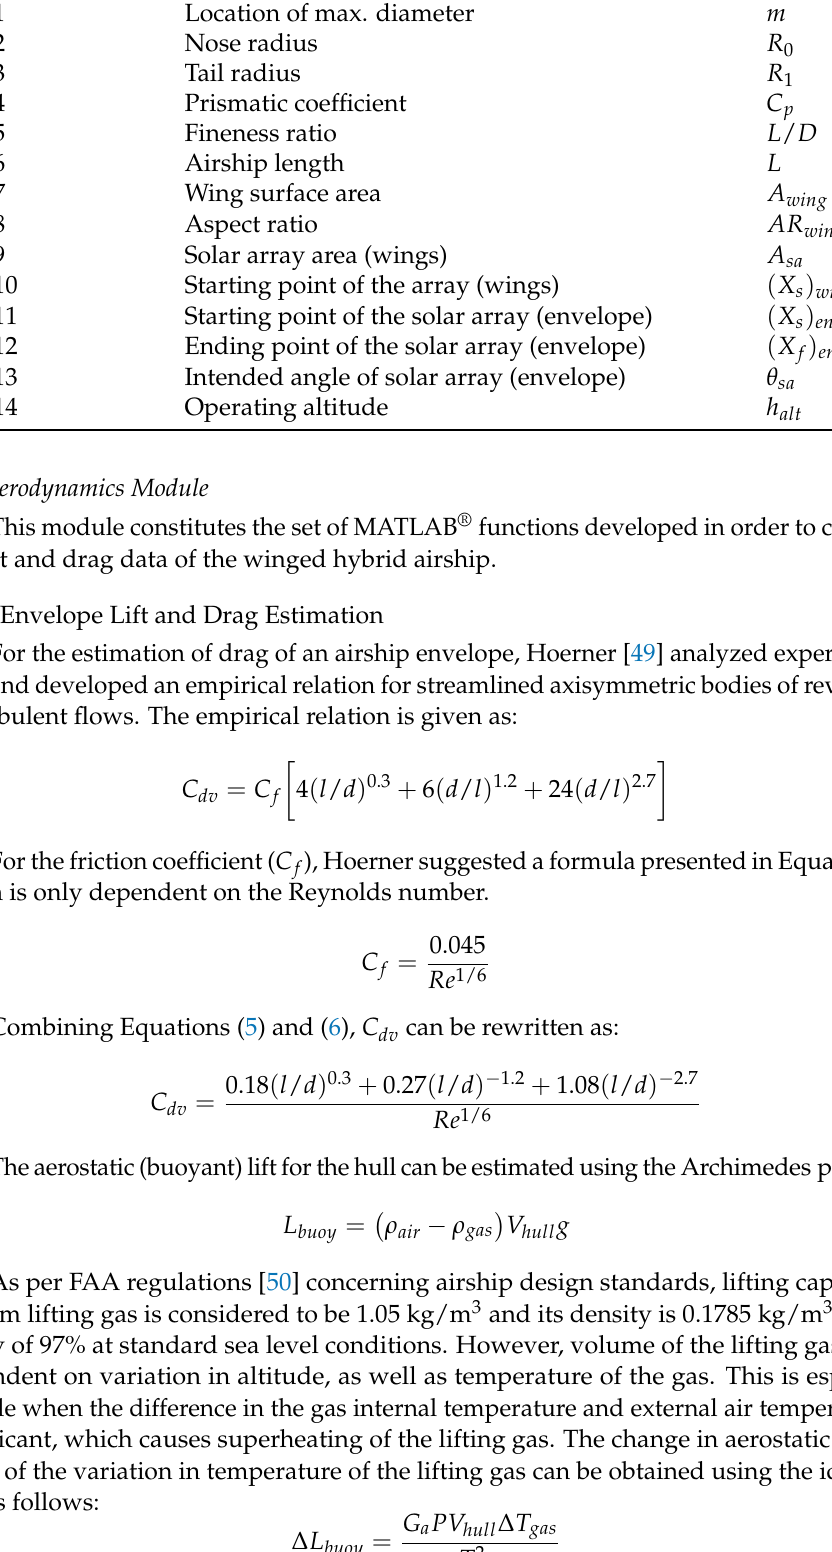
Table 2. List of design variables. Sr.